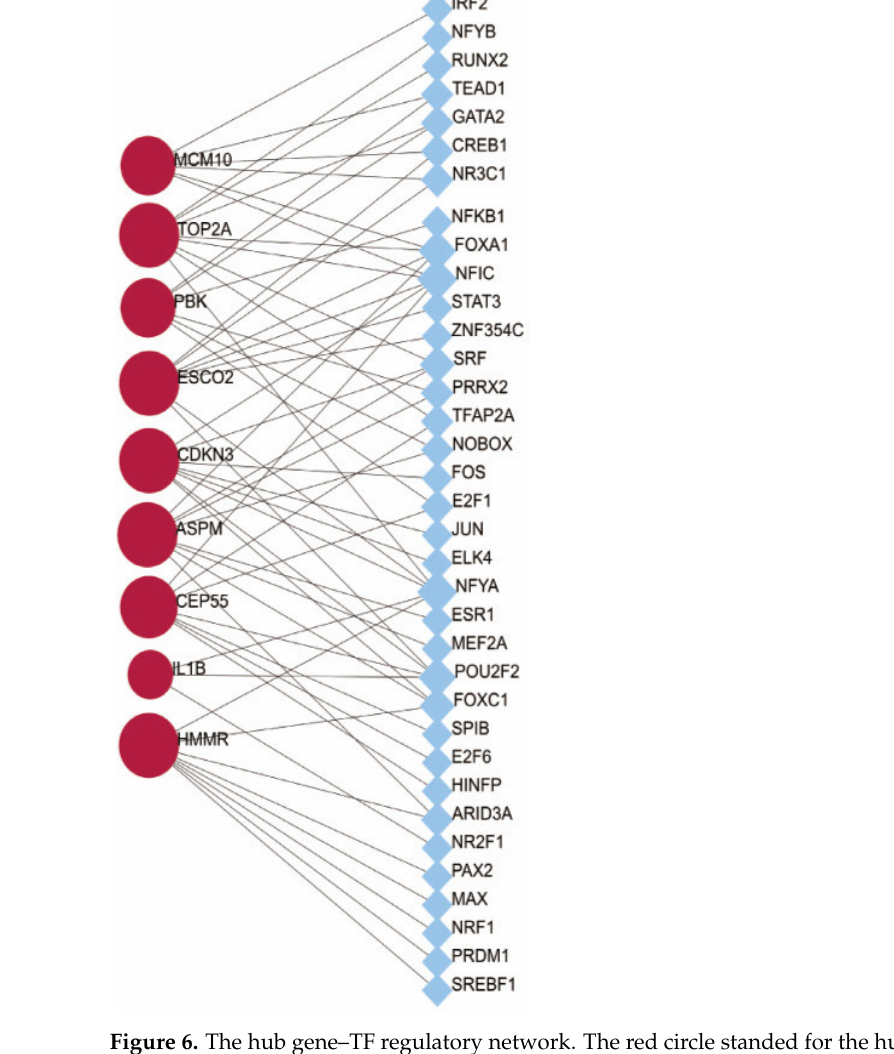
Figure 6. The hub gene–TF regulatory network. The red circle standed for the hub gene and the blue node standed for the transcription factor.